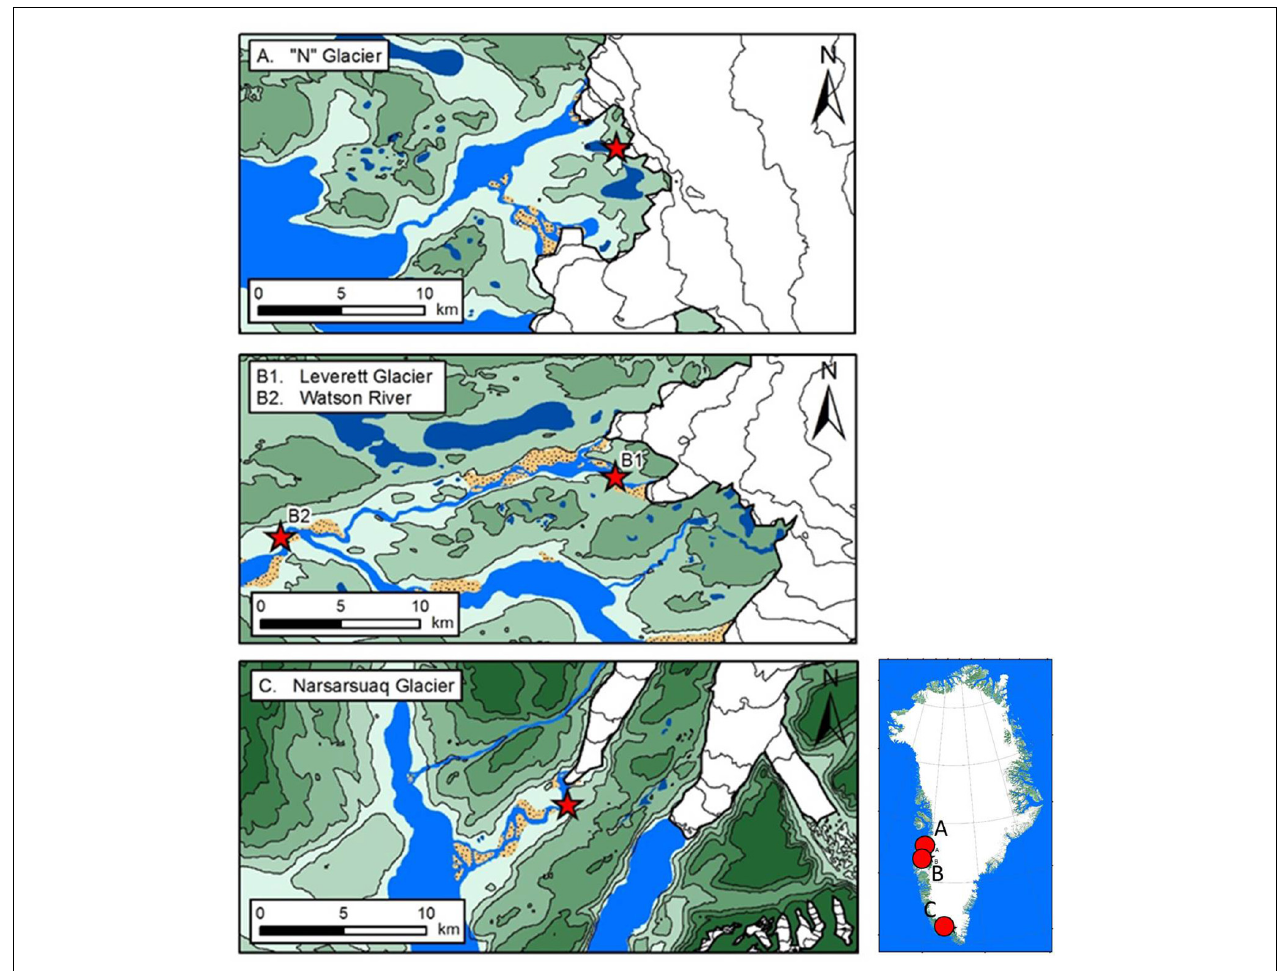
FIGURE 1 | Bulk meltwater samples were collected from: (A) “N” glacier, with catchment boundaries from Bhatia et al. (2013a), (B1) location of Leverett glacier with sampling sites from Hawkings et al. (2014; 2015; 2016), (B2) location of Watson River with sampling site, and (C) Kiattuut Sermiat glacier with monitoring site from Hawkings et al.